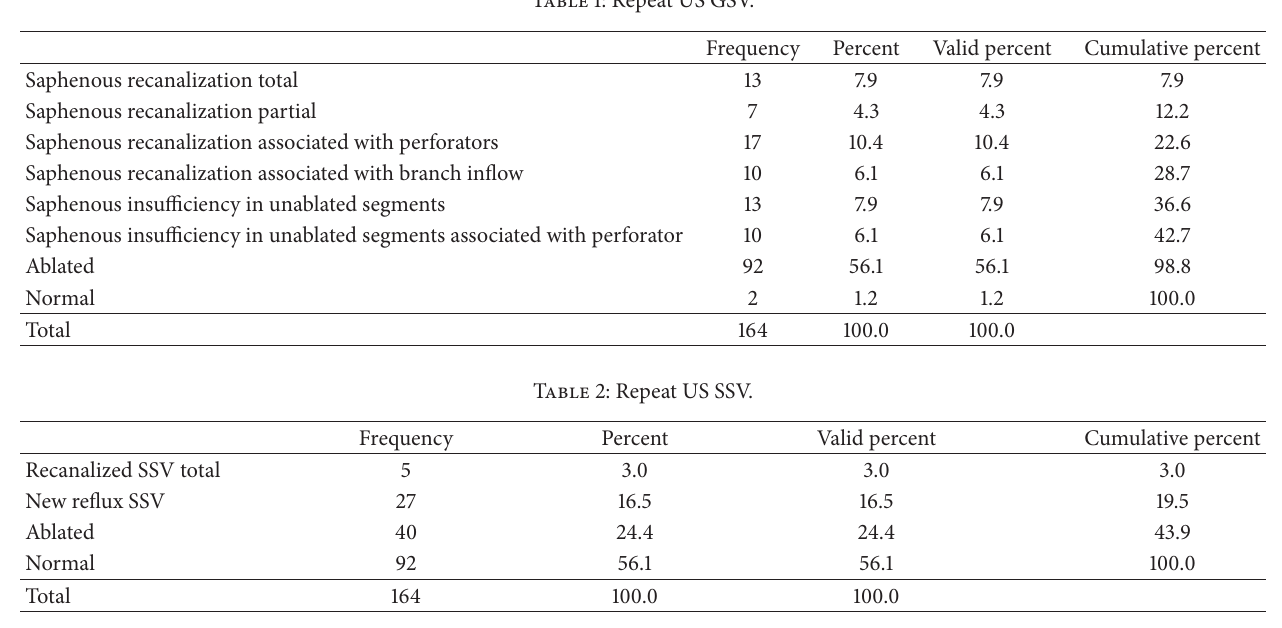
Table 1: Repeat US GSV.